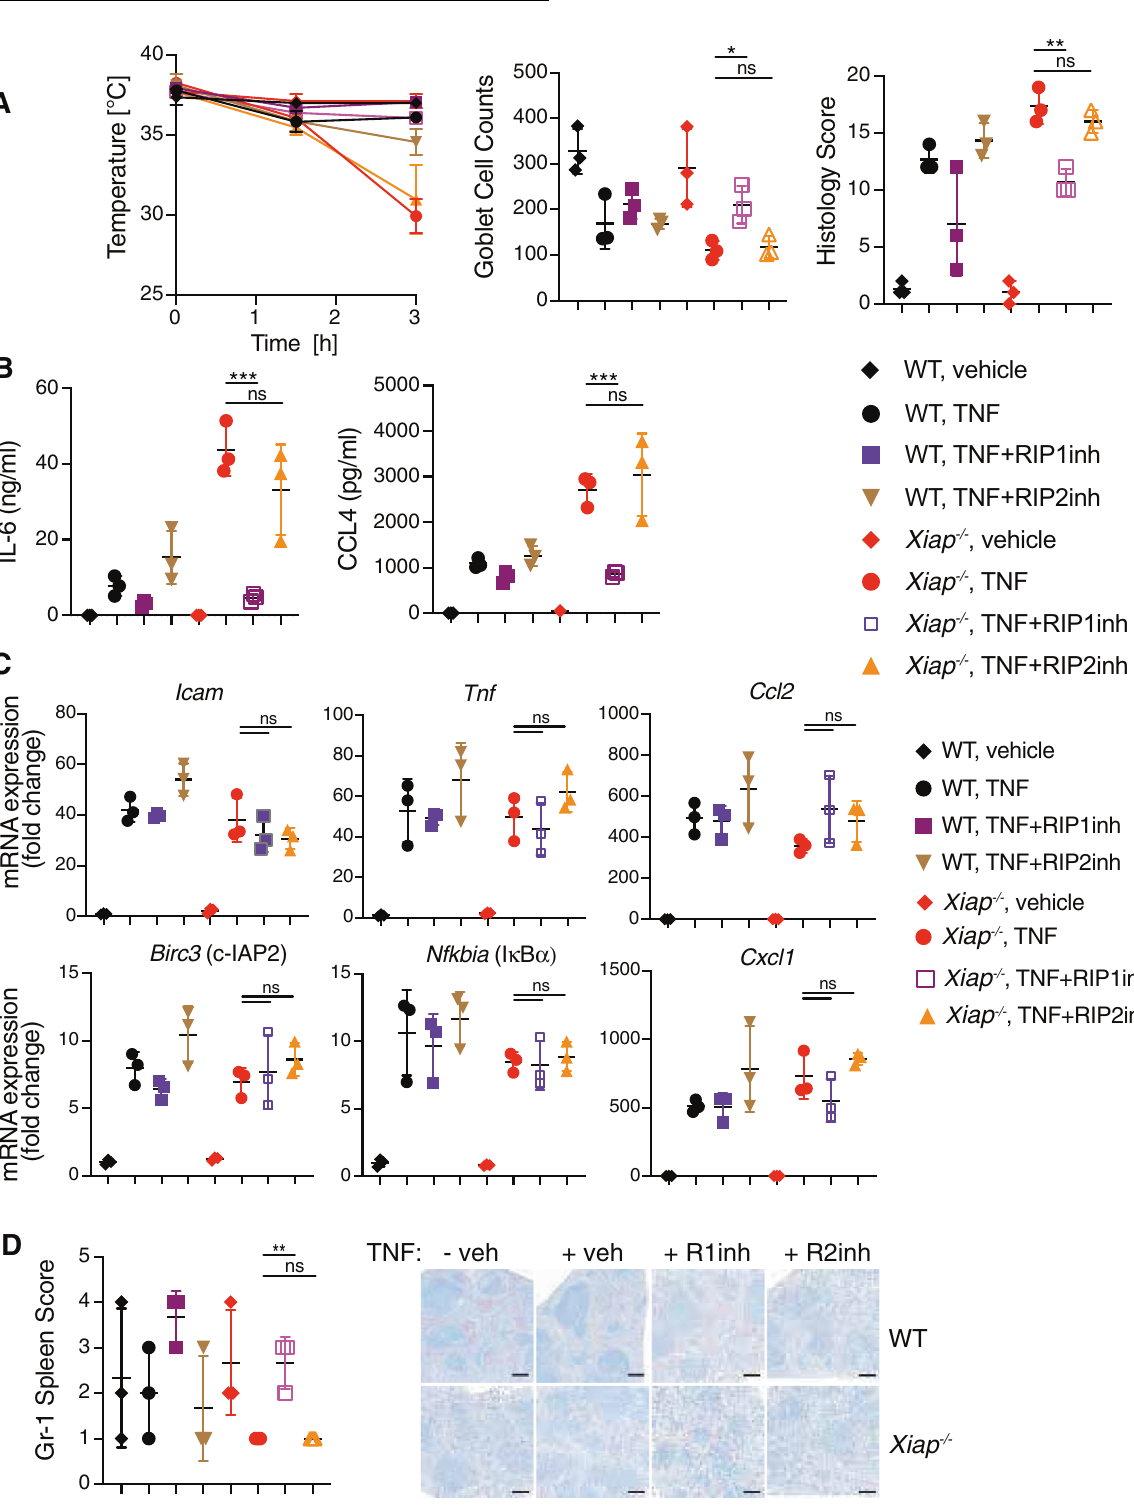
(Thermo Scienti fi c). Tissues were lysed for 30 min at RT and centrifuged at 14,000 rpm for 10 min at 16 °C. Lysates were resolved on SDS-PAGE and immunoblotted with the indicated